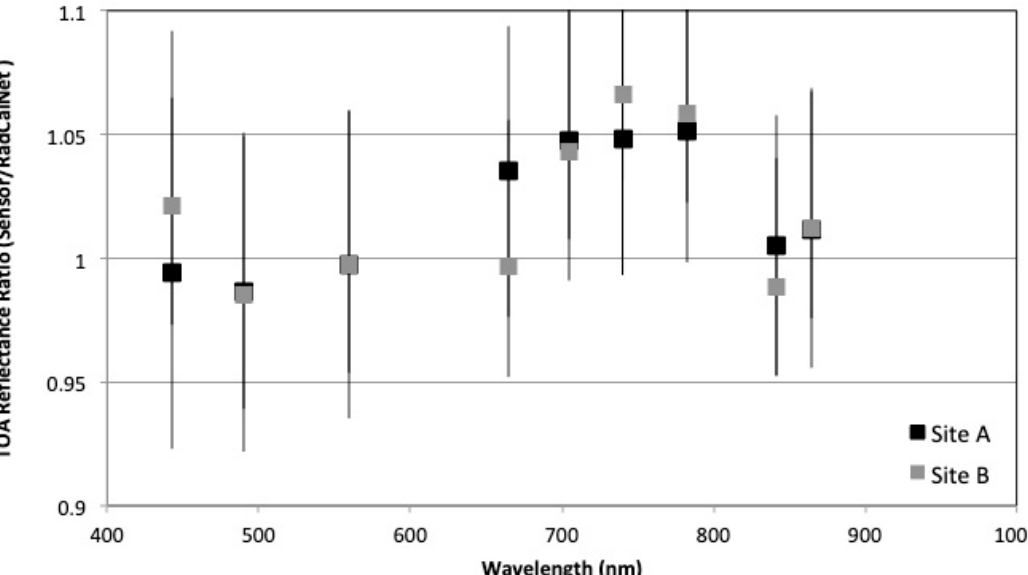
Figure 9. Results from Sensor 2 at sites A and B. Uncertainty bars are based on the standard deviation of the temporal averages.